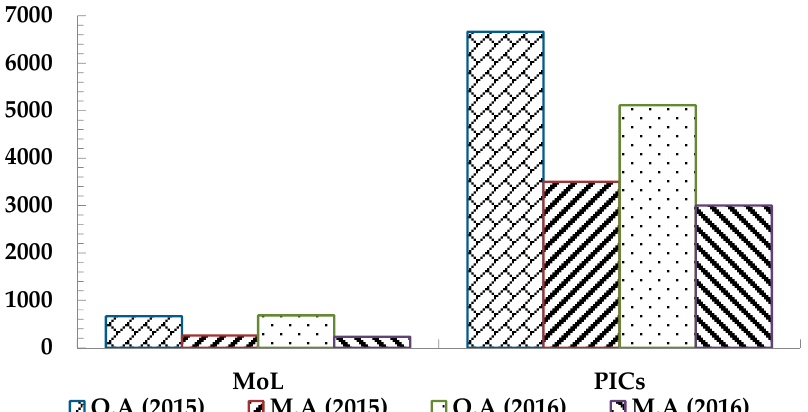
Figure 1. Number of manufacturing accidents and the total occupational accidents according to the Ministry of Labor (MoL) and the Palestinian insurance companies (PICs) reports (2015/2016), where O.A = Occupational Accidents, M.A = Manufacturing Accidents.